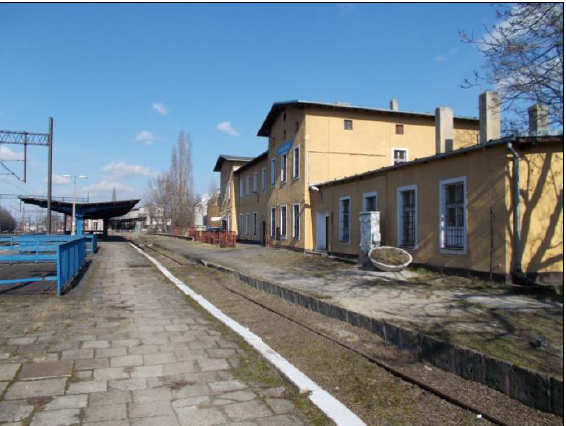
Fig. 3. The railway station building in Mysłowice, 2014 ( W. Dragan